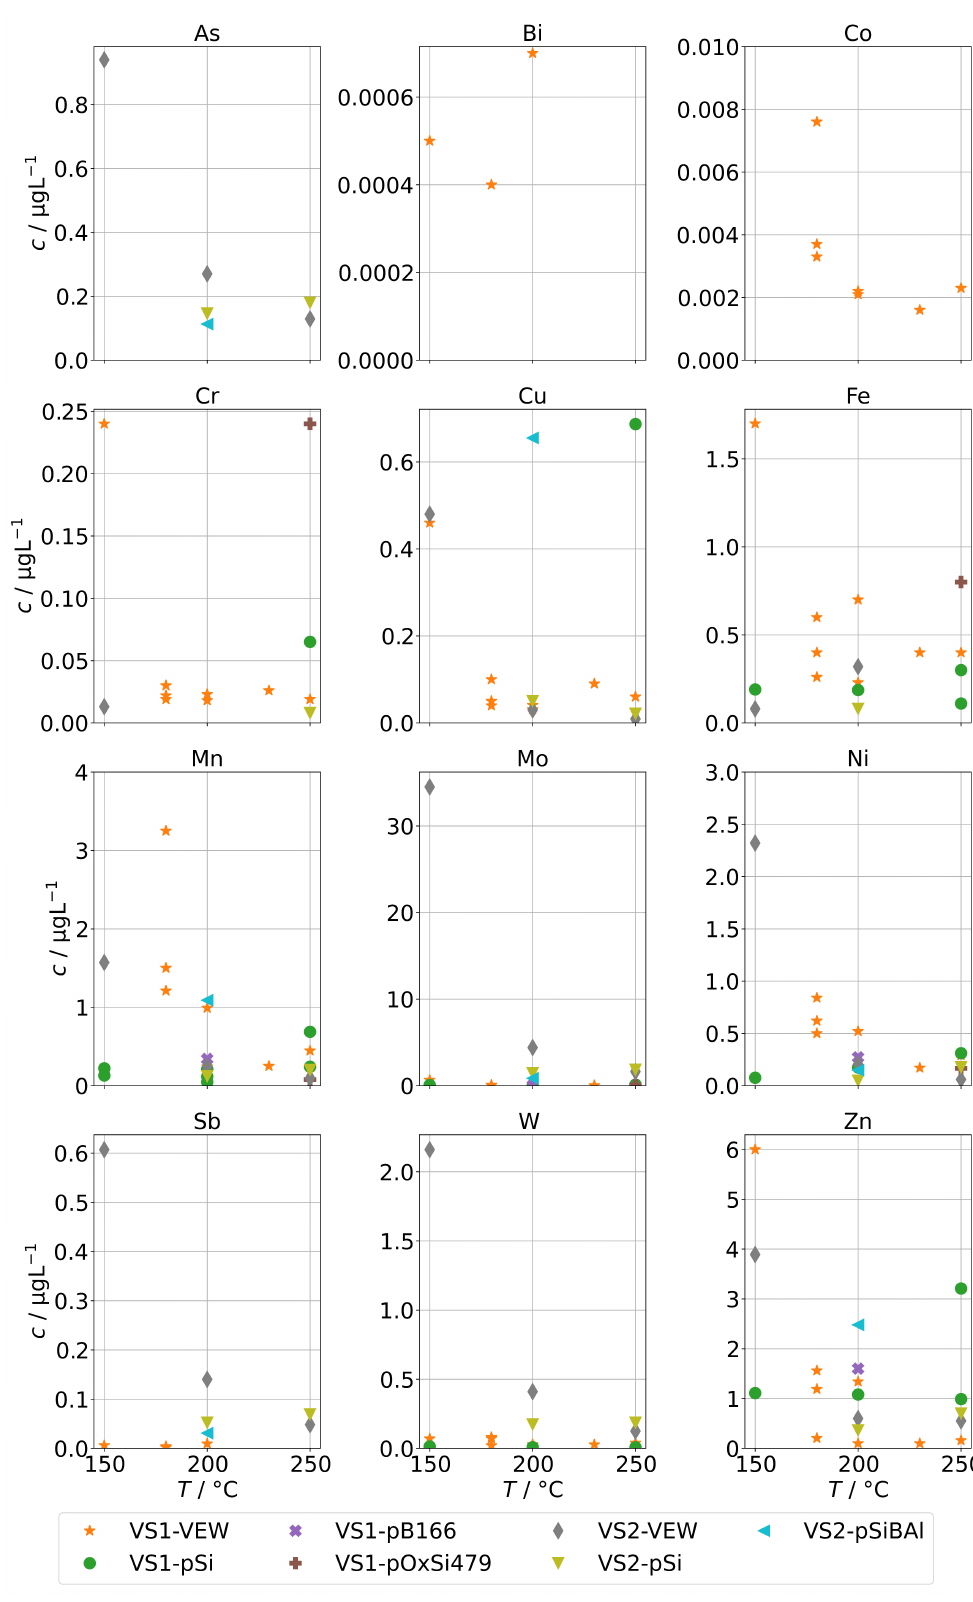
Figure 5. Background concentrations of quantifiable species in condensates of the SB-SG (group A) in dependence of operation